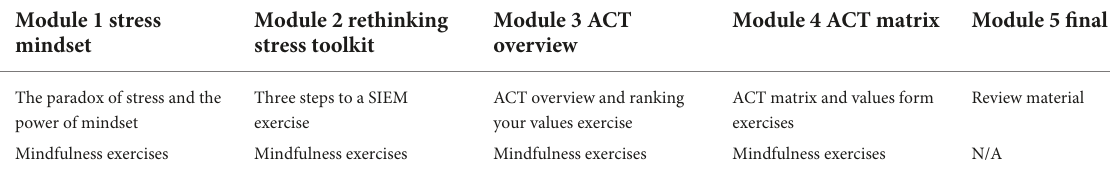
TABLE 1 Modules of the “ReStress Mindset”